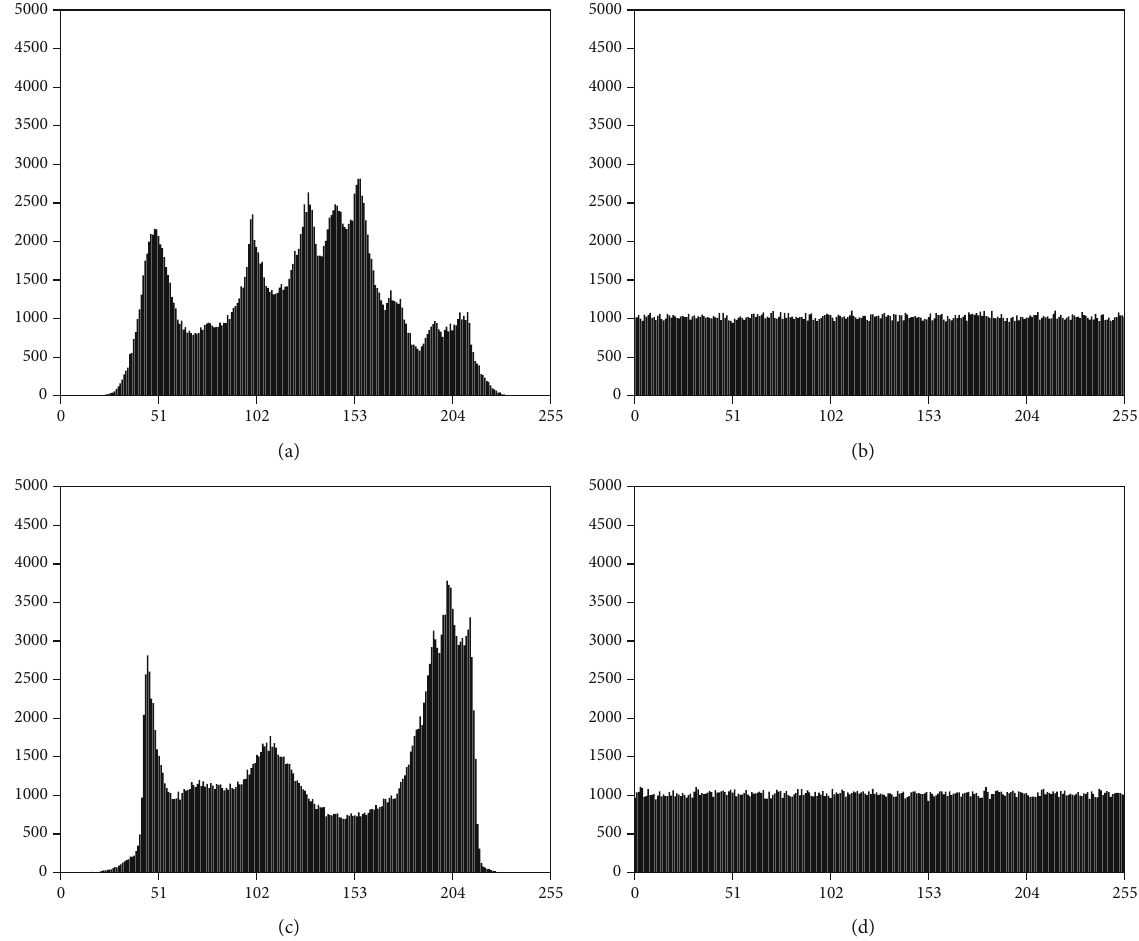
Figure 10: Histogram analysis. (a) Histogram analysis of Lena. (b) Histogram analysis of encrypted Lena. (c) Histogram analysis of Reagan. (d) Histogram analysis of encrypted Reagan. Table 4: Chi-square test results.